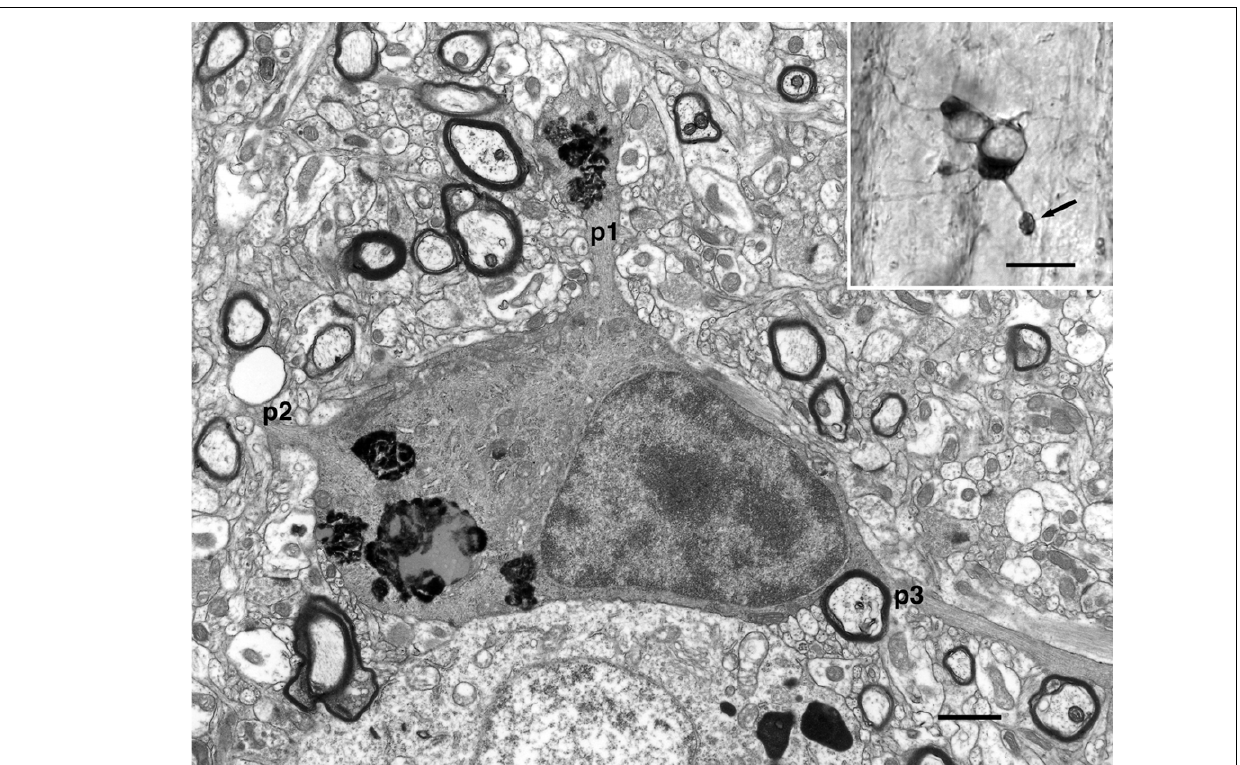
FIGURE 4 | Electron micrograph of an oligodendrocyte in layer 6 of area 17 of a 35-year-old rhesus monkey. Three processes, p1–p3, extend from the cell body. One of the processes, p1, has a swelling that contains dense inclusions, which are similar to the dense inclusions in the cell body. Scale bar = 1 micron.